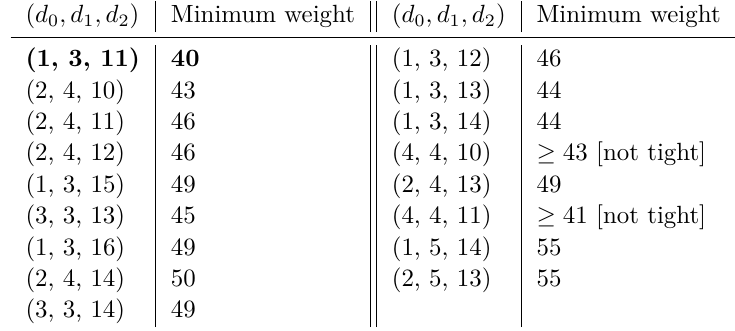
Table 4: Minimum weights for 3-round differential trails corresponding to specific configu- ration of active